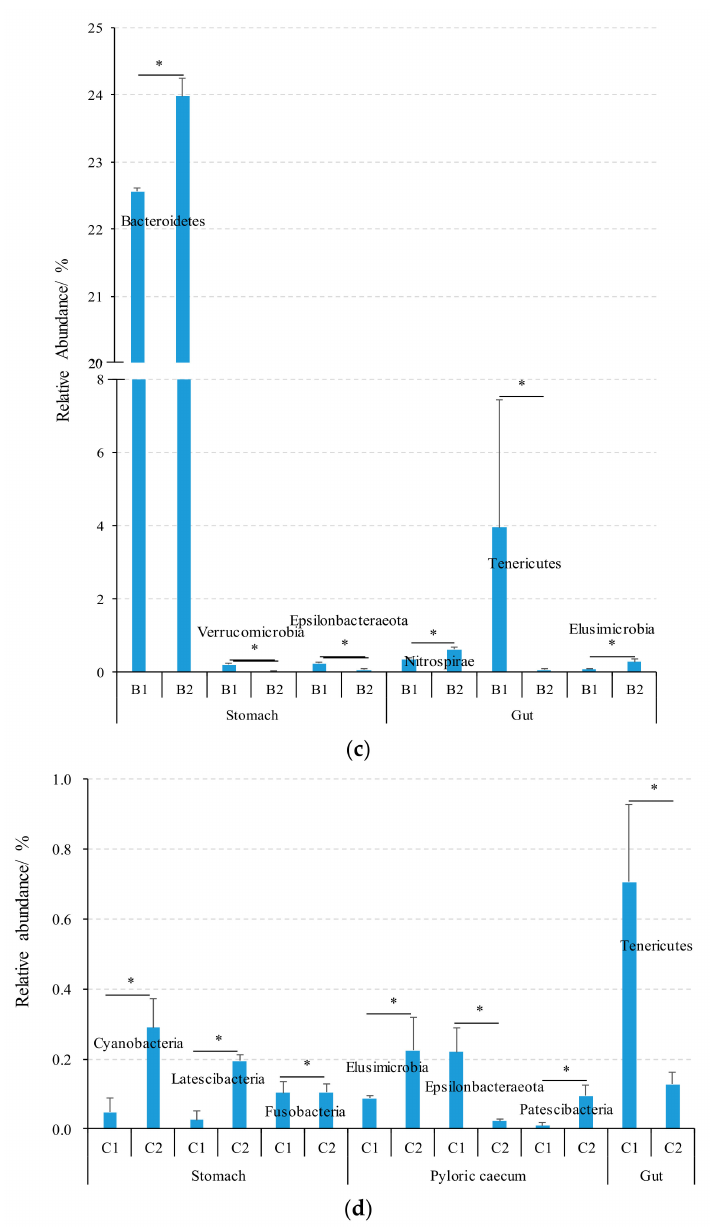
Figure 3. The dominant (top ten, according to the average relative abundances of the three parallel samples for each gastrointestinal tissue in each treatment) phyla with significant differences in the gastrointestinal tracts of yellowtail kingfish. Notes: ( a ) among the three different density groups at the beginning and end of the study; ( b ) between the beginning and end of the study for the low-density group; ( c ) between the beginning and end of the study for the medium-density group; ( d ) between the beginning and end of the study for the high-density group. A1, B1, and C1 represent the low-, medium-, and high-density groups at the beginning of the study, while A2, B2, and C2 represent the low-, medium-, and high-density group at the end of the study. * represents significant differences for the same phylum between the beginning and end of the study in each density group ( p ≤